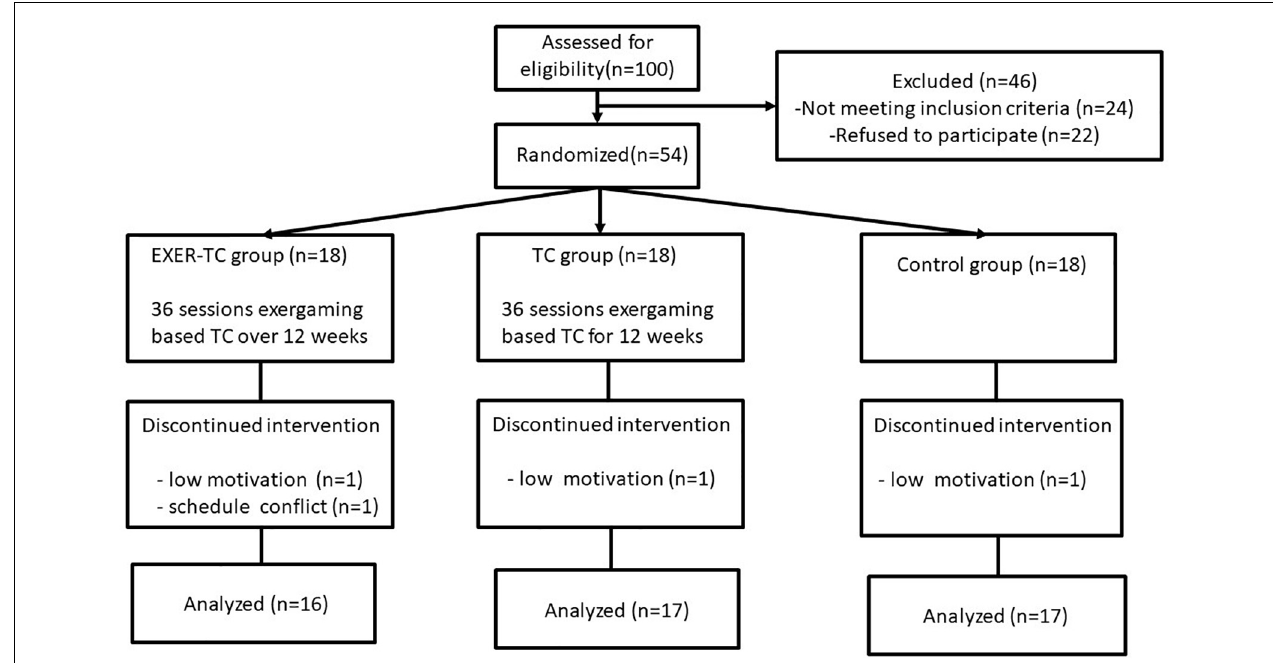
FIGURE 1 | Flow chart of the study design.